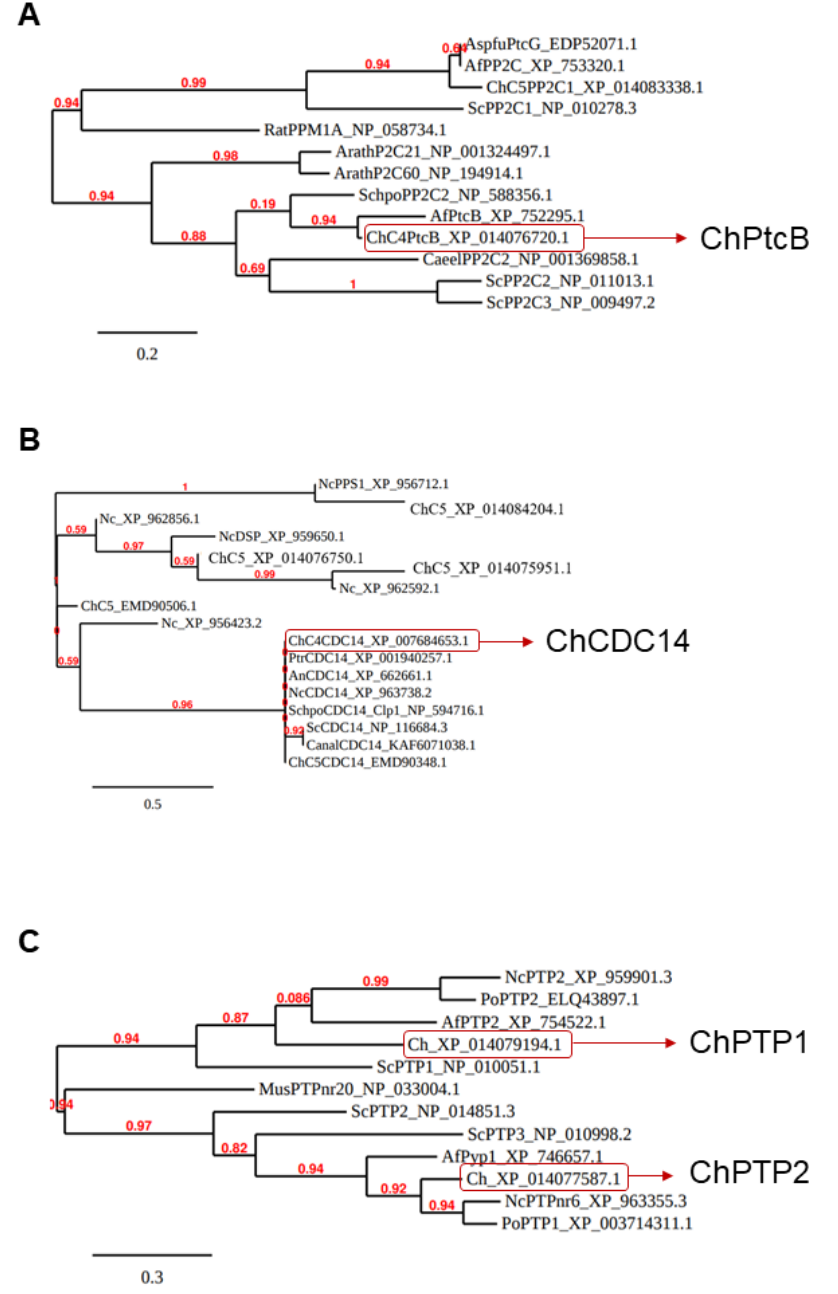
Figure 1. C. heterostrophus candidate phosphatase-encoding genes. ( A – C ) Following reciprocal BLASTP searches, the phylogenetic trees of the predicted C. heterostrophus phosphatase candidate ortholog genes were generated using the Phylogeny.fr pipeline (for details, see Methods and the legend to Table 2). Each entry in the trees starts with an informative gene name (organism: Nc, Neurospora crassa ; Ch, Cochliobolus heterostrophus ; Mus, mouse, Cael, C. elegans ) followed by an abbreviated phosphatase class name and, last, the NCBI protein database